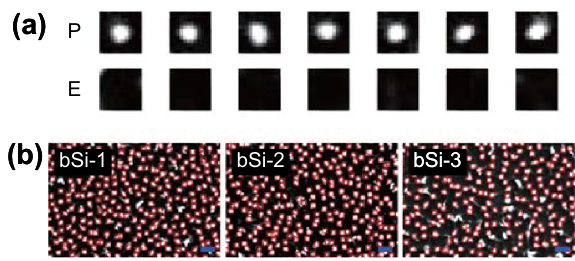
Fig. 1 Identification and detection of the nanopillars of the black silicon surfaces. a Training set based on the SEM images of bSi-1 ( 9 10,000 magnification) used to distinguish pillar tips and free regions between the pillars. P: pillar tip; E: empty space between pillars. b Detected pillar tips (red squares) on each type of bSi surface. Scale bars correspond to 500 nm. (Color figure